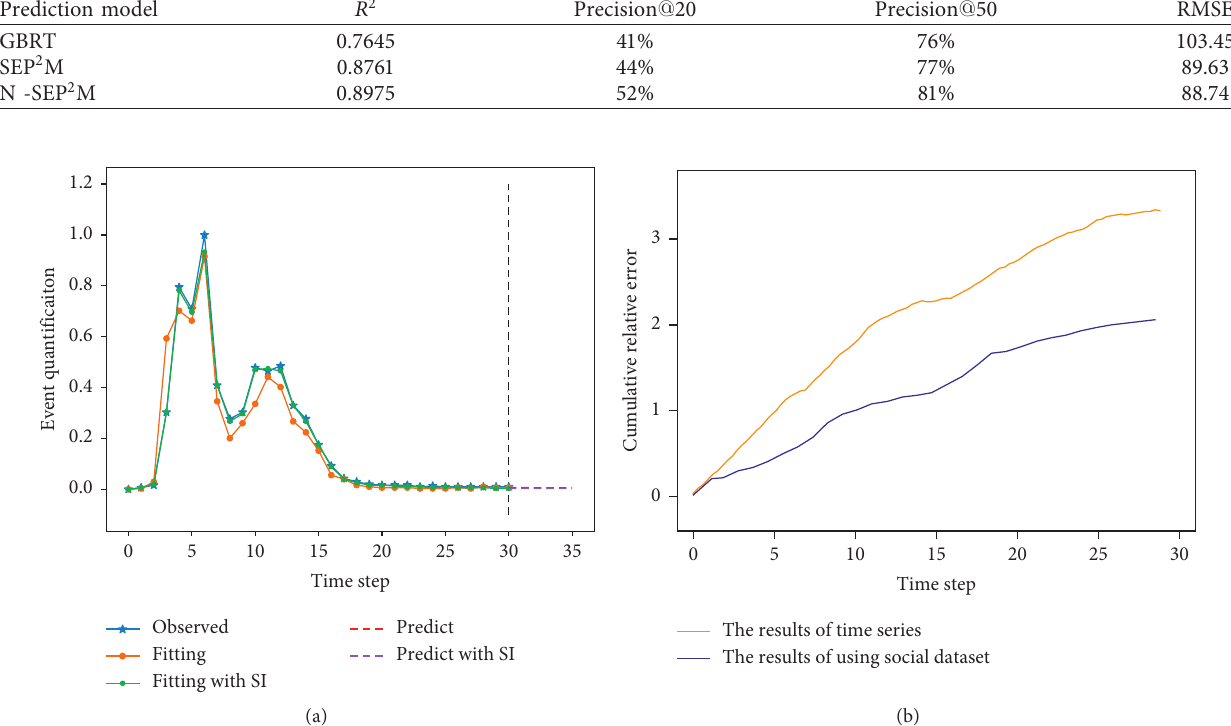
Figure 9: Popularity evolution prediction of social event: “Chengdu female driver was beaten by changing routes.” (a) Prediction accuracy comparison. (b) Cumulative relative error analysis. The predicted result of the NSEPP model with explanatory variables is the closest to the actual evolution. Social intensity can significantly reduce the cumulative error.